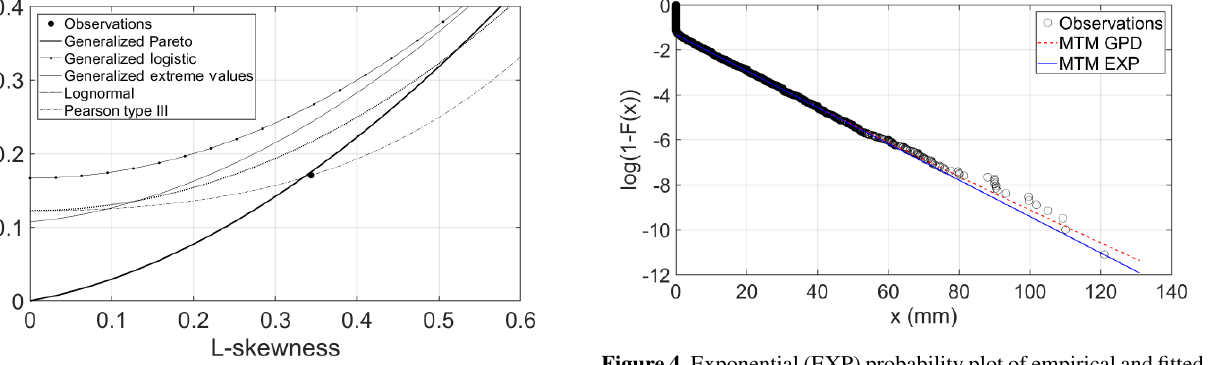
Figure 3. Theoretical L-moment ratio of common distribution mod- els, as compared to the sample L-moment ratios of daily rainfall time series at the Gioi Cilento weather station (large filled circle).